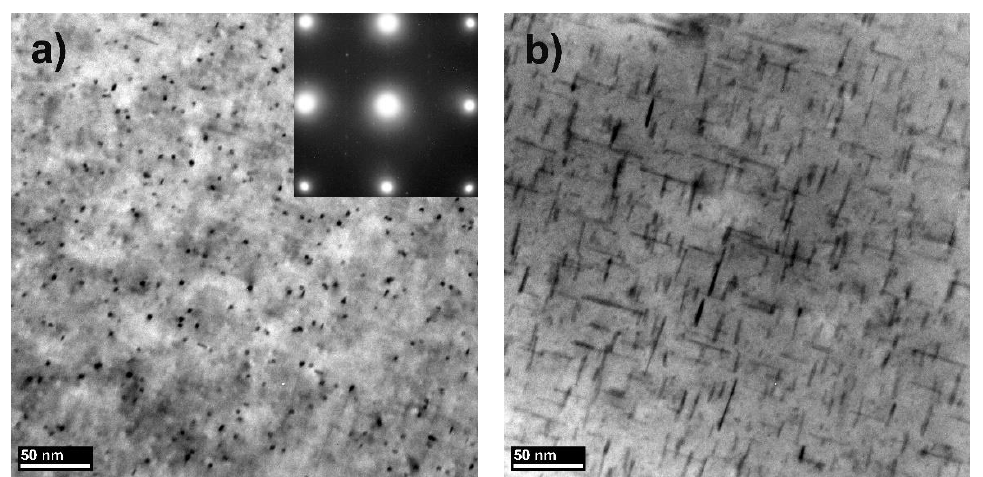
where the L phase is believed to be a Q’ precursor.